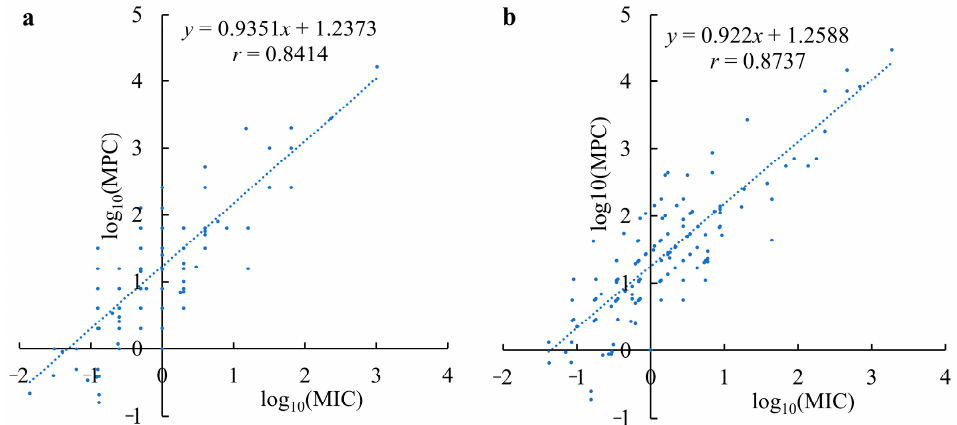
Figure 2. Correlations between the natural logarithm (log 10 ) of MIC and that of MPC. ( a ), the concentration units of the MIC and MPC were μ g/mL; ( b ), the concentration units of the MIC and MPC were μ M/L.